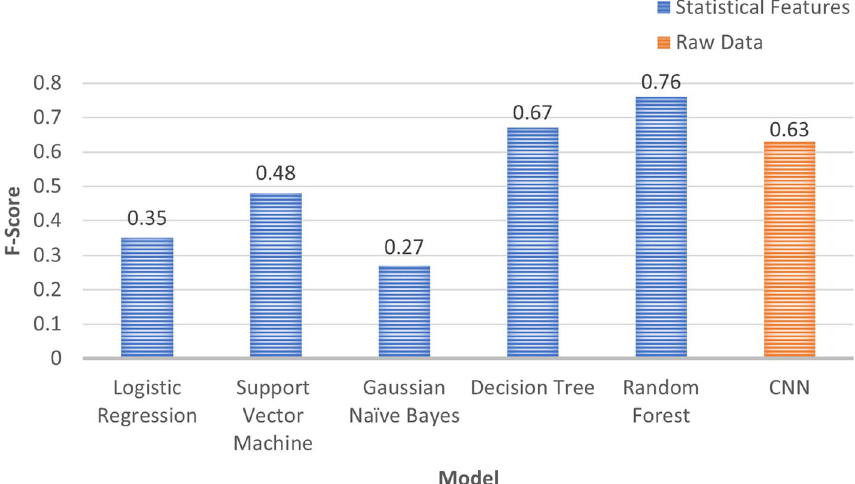
Fig. 13 Comparison of classification models trained using statistical features and raw data from a